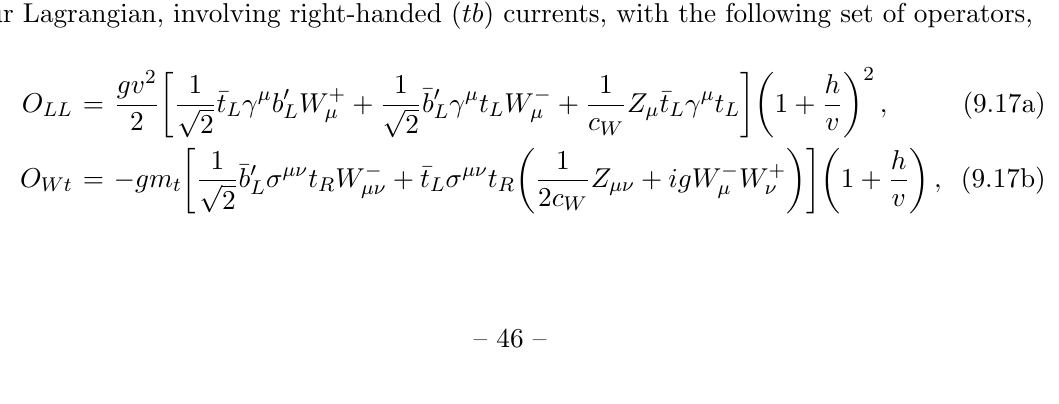
Figure 17 . A 3 and A 5 coe(cid:14)cients in W + H production as a function of p W of p W . A vanishes if parity is conserved in the production of the W boson, and, for 3 T cut the chosen value of (cid:24) , this e(cid:11)ectively occurs at p W ud overtakes the SM contribution and the sign of A